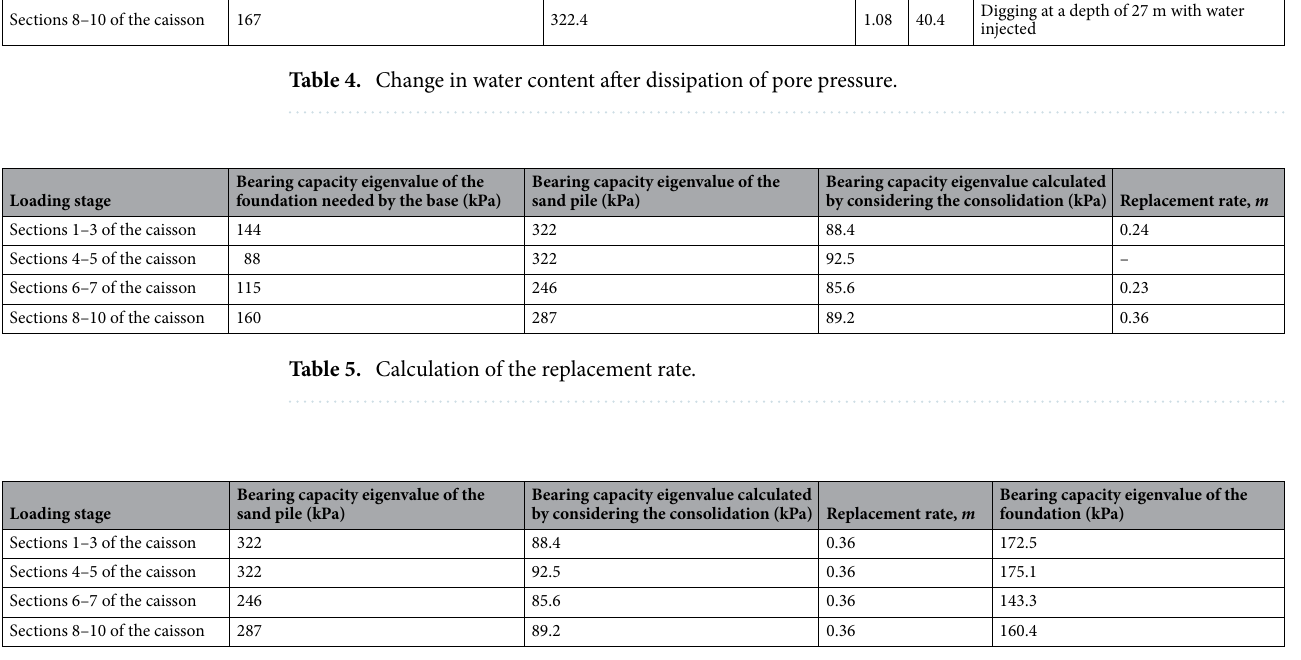
Table 6. Bearing capacity eigenvalue after foundation